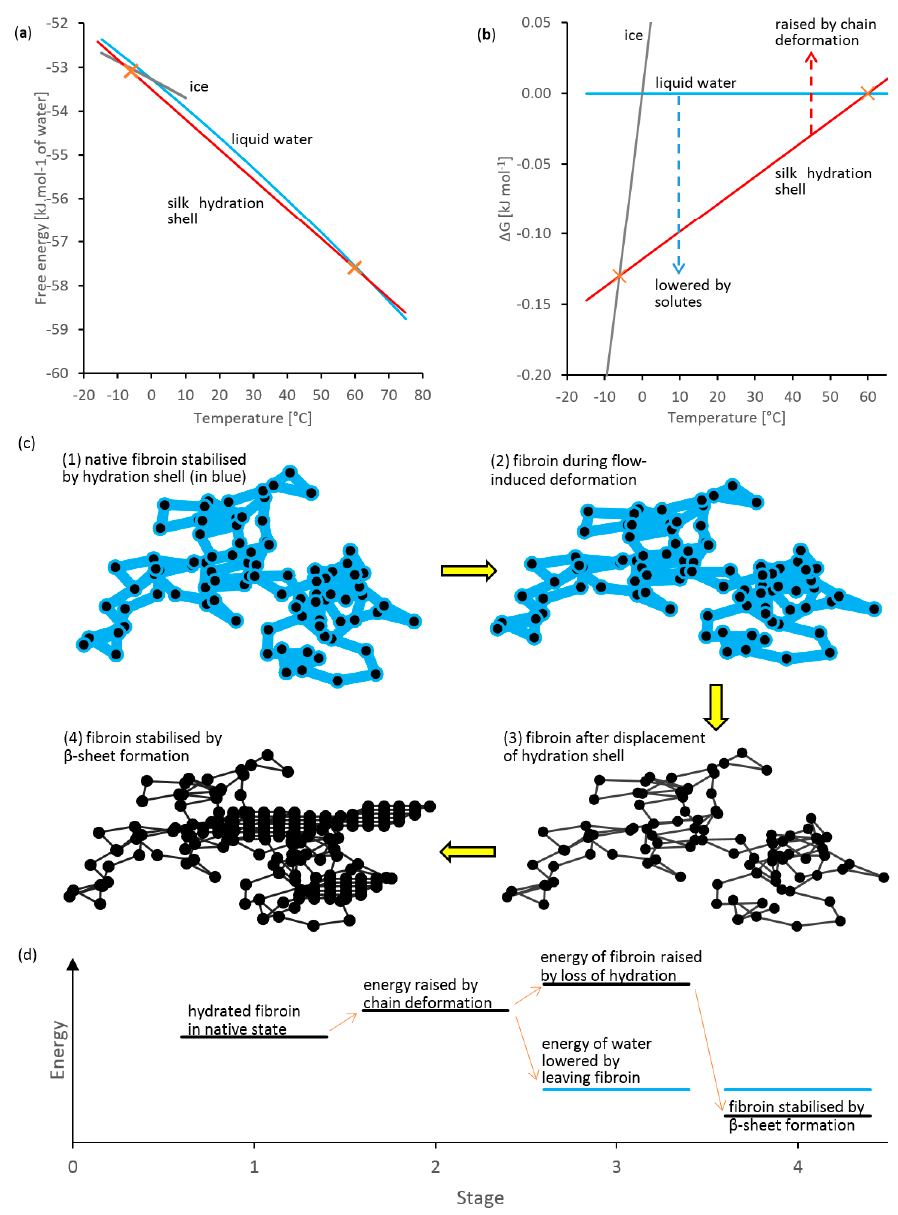
Figure 8. Representative illustration of entropy-driven de-solvation hypothesis: ( a ) free energy vs. temperature plots for ice (grey), water (blue) and fibroin hydration shell (red); ( b ) free energy change from liquid water to ice and hydration shell (assuming linear interpolation); ( c ) representing four stages of flow-induced coagulation (random coil, native hydrated fibroin, flow-induced chain deformation, loss of hydration and β -sheet formation); ( d ) corresponding energy changes.